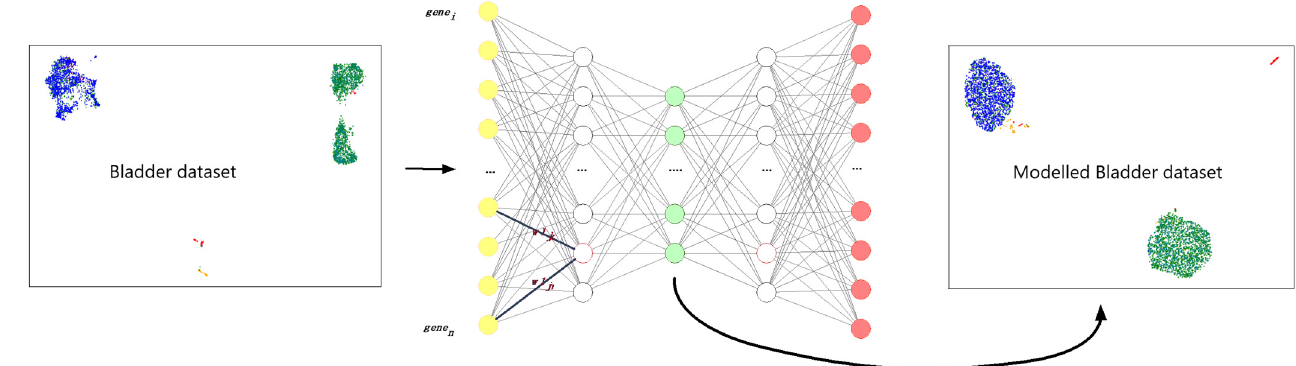
Figure 1. Overview of data visualization and autoencoder. UMAP of raw data (left), autoencoder architecture (center), UMAP of encoded data (right). In the autoencoder nodes in the input layer are yellow, the bottleneck layer nodes are green and output layer nodes are red. “…” indicates additional nodes not displayed in the graphics.